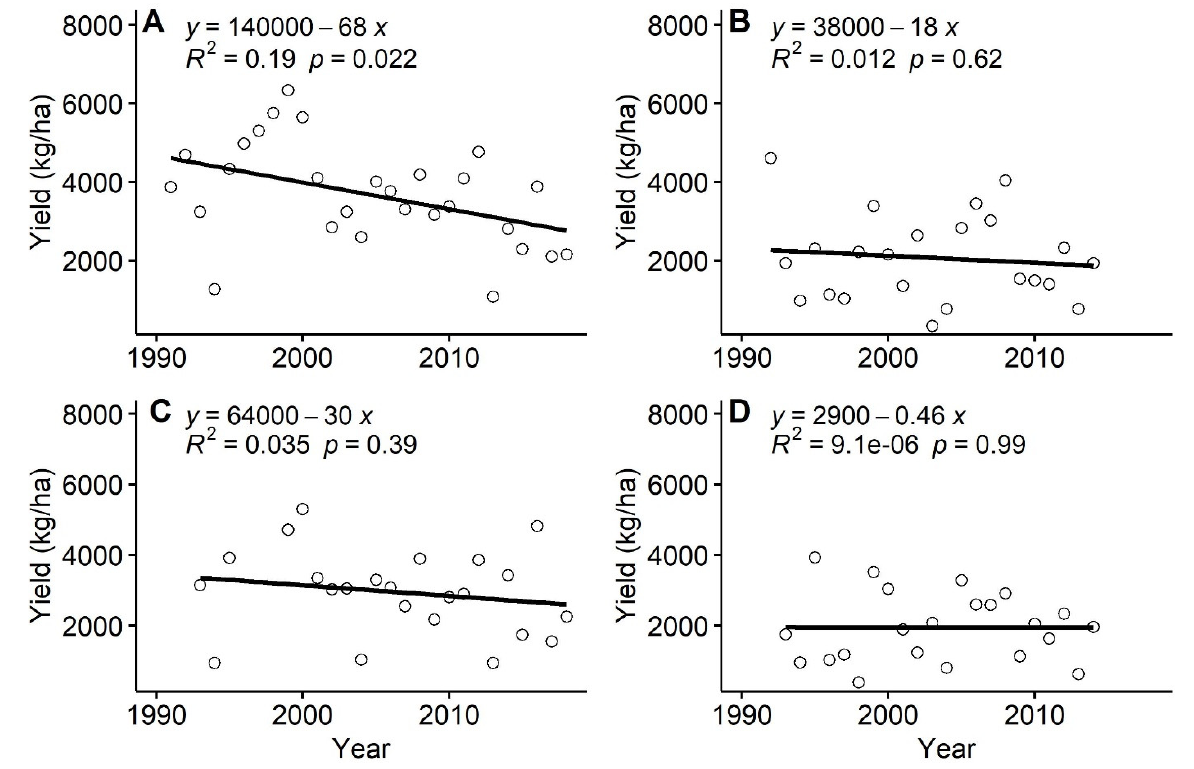
Figure 3. Linear yield changes of barley cultivar ‘Otal’ and ‘Thual’ in Fairbanks from 1991 to 2018 and Delta Junction from 1992 to 2014. ( A ) ‘Otal’ in Fairbanks; ( B ) ‘Otal’ in Delta Junction; ( C ) ‘Thual’ in Fairbanks; ( D ) ‘Thual’ in Delta Junction.